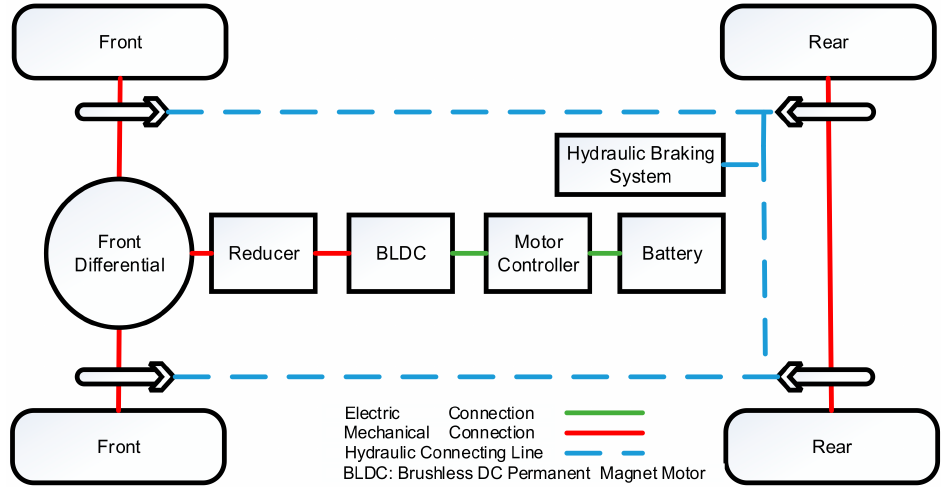
Figure 3. Topological structure of the battery electric vehicles (BEV) platform.